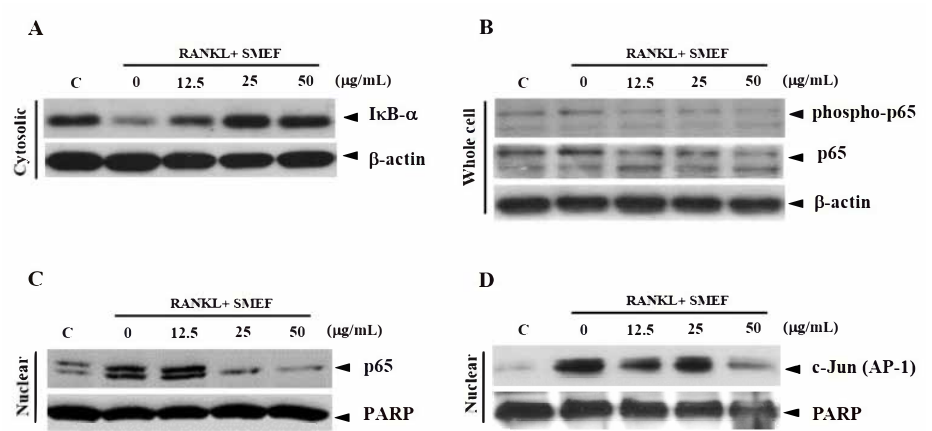
Figure 4. SMEF suppresses RANKL-induced NF- κ B and AP-1 activation in dose-dependent manner. ( A – D ) RAW 264.7 cells were pretreated with SMEF (0, 12.5, 25, and 50 µ g/mL) for 12 h and then exposed to RANKL for 10 min. Cytosolic fractions were analyzed for protein content of I κ B- α degradation, whole-cell lysates were used to determine phosphorylation levels of NF- κ B p65, and blotting as described in the Materials and Methods